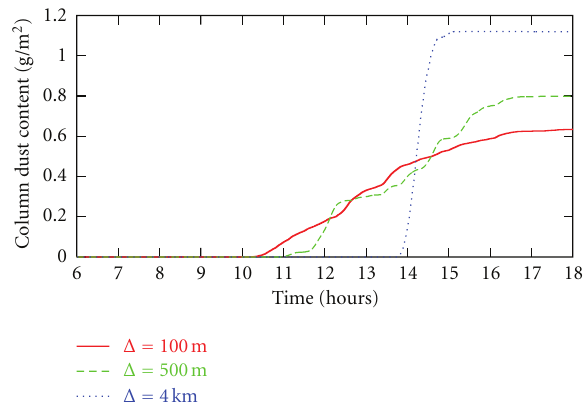
Figure 9: Column total dust content (in g m − 2 ) averaged over the computational area obtained from the EXP2 simulation (denoted as the red line) and the sensitivity simulations with the horizontal grid spacing of 500m (the green line) and 4km (the blue